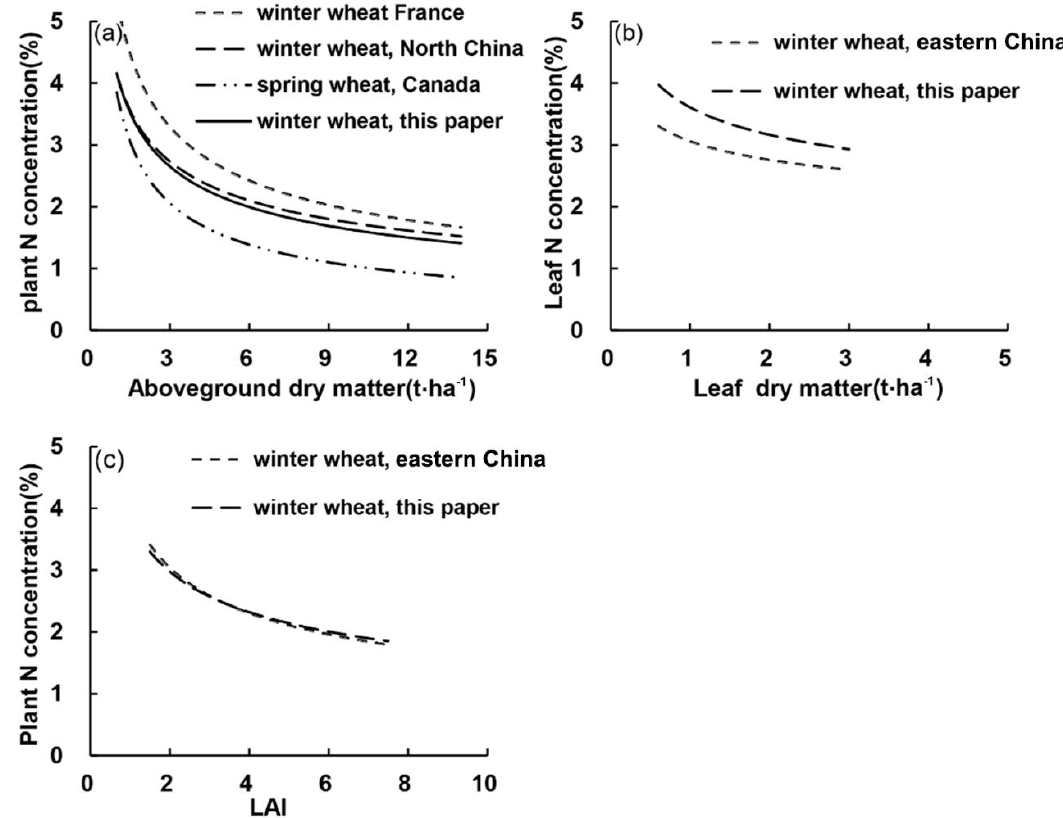
Figure 8. Comparison of the critical nitrogen dilution curves with other curves in wheat on di ff erent bases ( a ): plant dry matter basis; ( b ): leaf dry matter basis; ( c ): leaf area index basis.